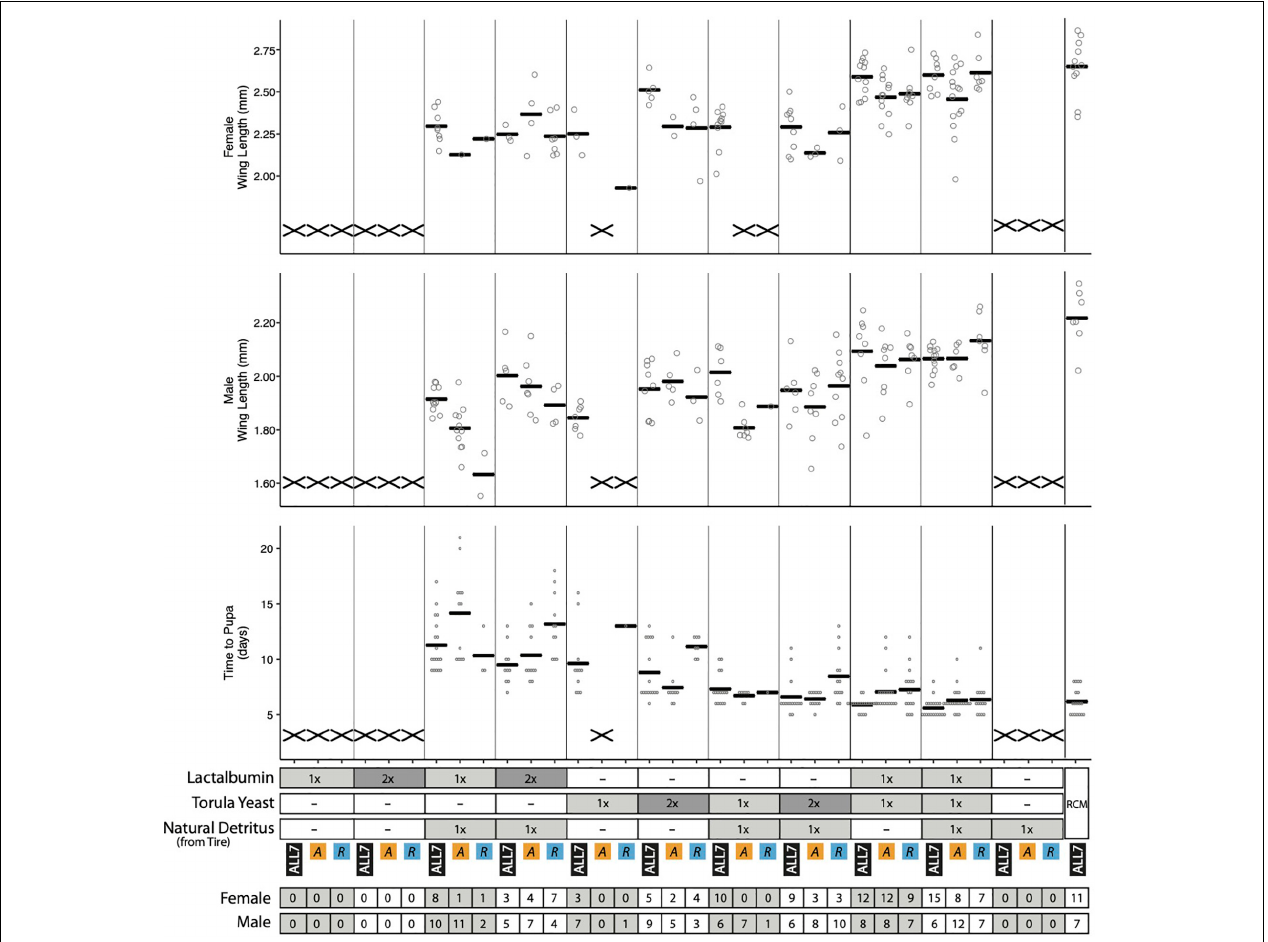
FIGURE 5 | Performance metrics of A. aegypti reared on diet combinations of lactalbumin, torula yeast, and natural detritus. For each diet composition, mosquitoes were reared with three microbiotas: ALL7, Acinetobacter (A), and Rahnella (R). Bars indicate mean abundance for the treatment. The “X” marks at the bottom of data columns for “Time to Pupa” and “Wing Length” indicate that larvae did not develop into pupae or adults, respectively. Positive control mosquitoes were reared on RCM diet with the ALL7 microbiota. 1 × , diet provisioned at 1/3 quantity of RCM diet; 2 × , diet provisioned at 2/3 quantity of RCM diet; –, omitted from diet. The number of adult male and female mosquitoes is listed at the bottom for each